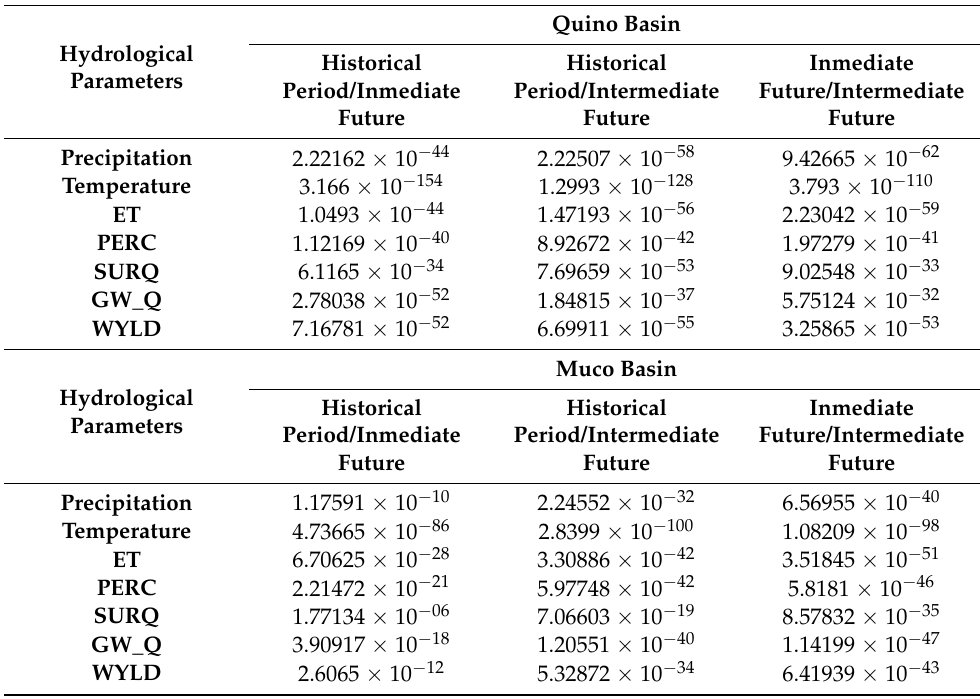
Table A1. Raw p _values for t-student mean comparison test: Climatic scenarios